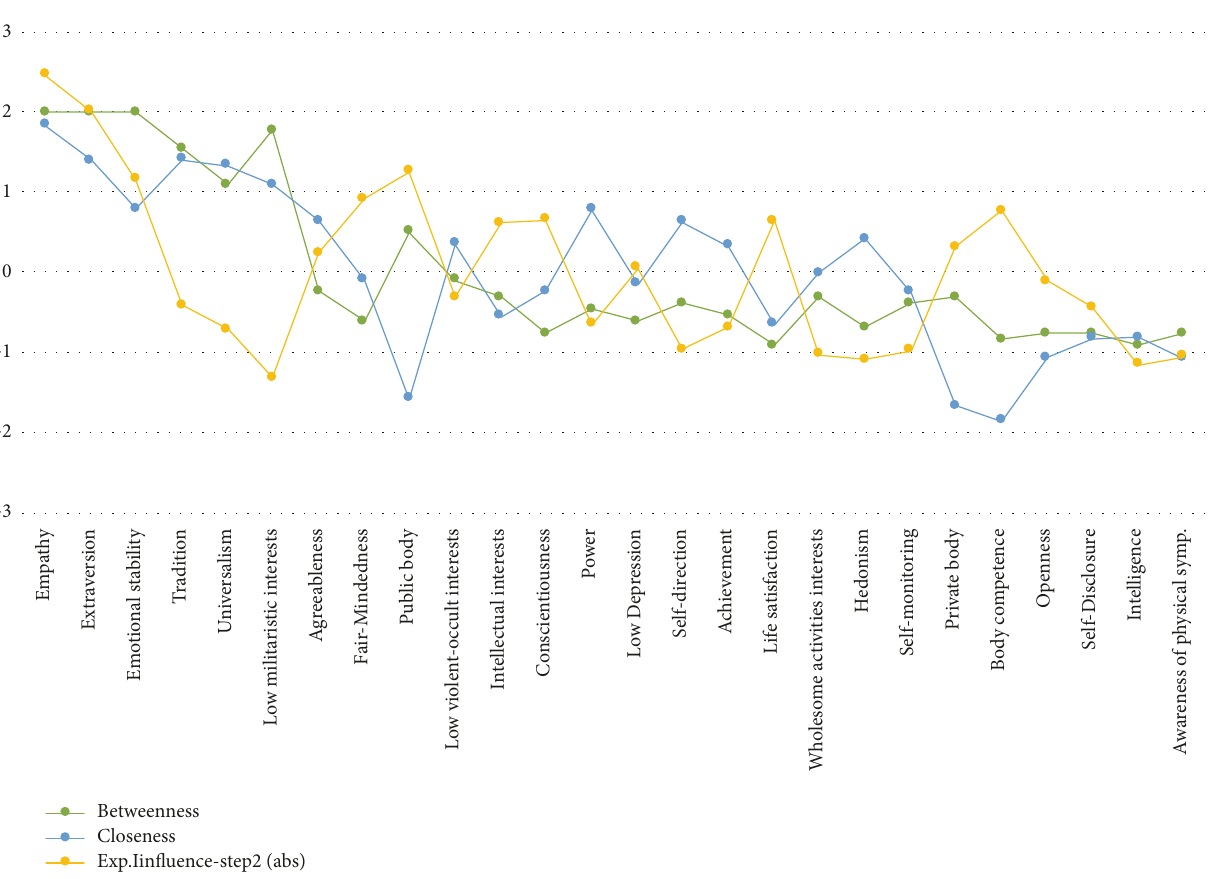
Figure 4: Centrality measures 2: based on links more than one distance away from the node (standardized values).